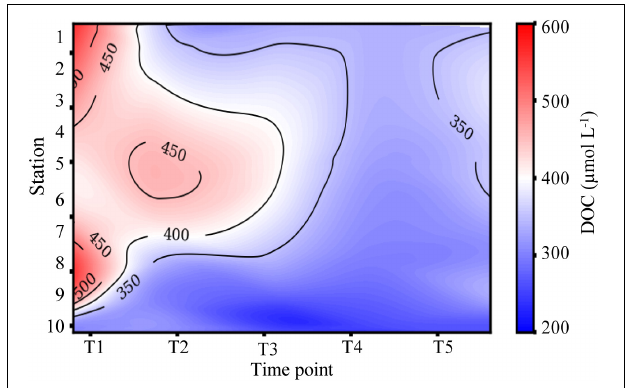
FIGURE 4 | Time series of dissolved organic carbon (DOC) from the mouth of the San Jacinto River to the Gulf of Mexico. Stations are indicated along the y -axis and time points are represented along the x